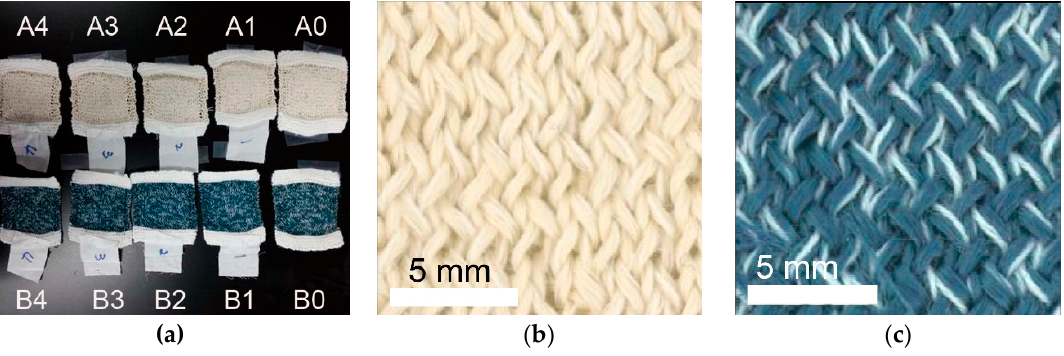
Figure 6. ( a ) An optical image of fabrics prepared from yarns based on PAN (A0 ‒ A4) and PAN/CPN nanocomposite fibers (B0 ‒ B4), and those of fabrics after washing, based on ( b ) PAN and ( c ) PAN/CPN nanocomposite fibers.